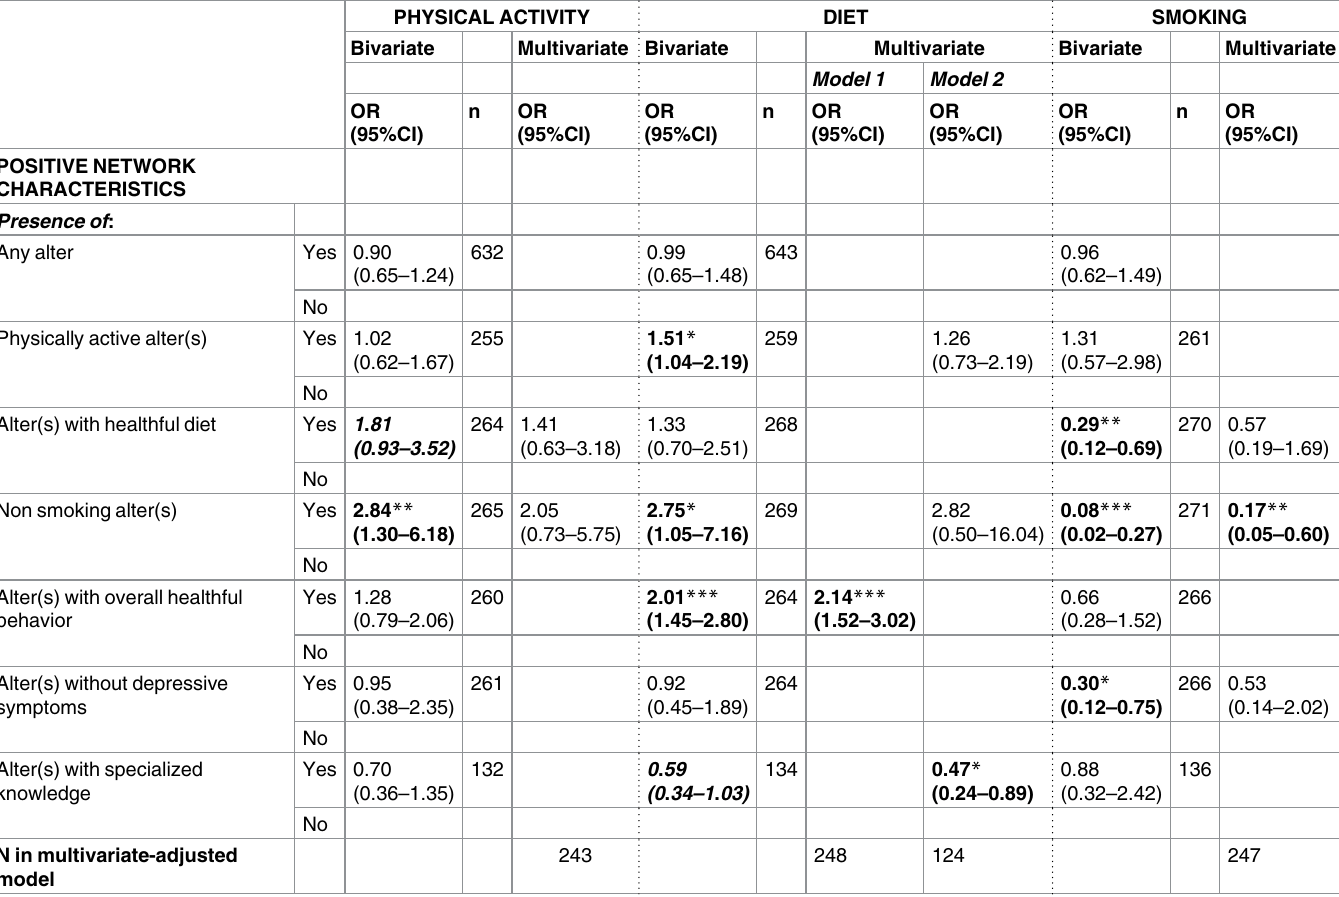
Table 2. Social network composition & patient health